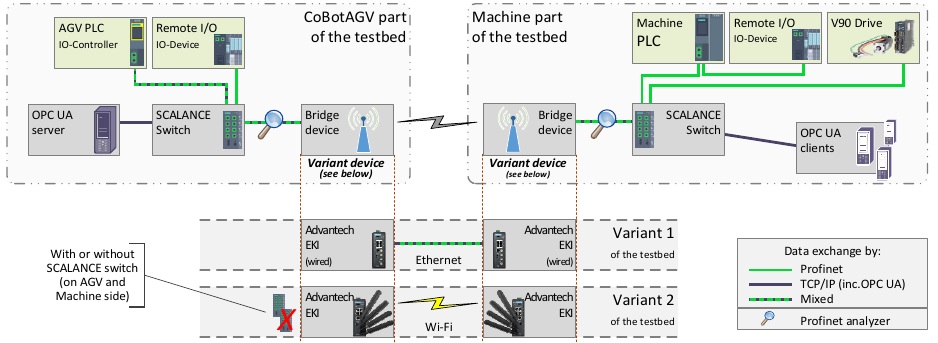
Figure 4. Profinet and OPC UA convergence—the two variants of the experimental research testbed: Variant 1: wired communication; Variant 2: wireless communication.